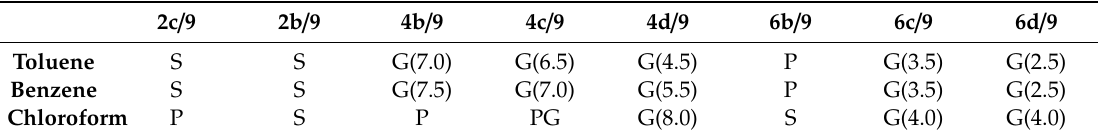
Table 3. Gelation properties of 1:1 mixture of catechol derivatives ( 2c , 2d , 4b – d , 6b – d ) and boronic acid 9 a